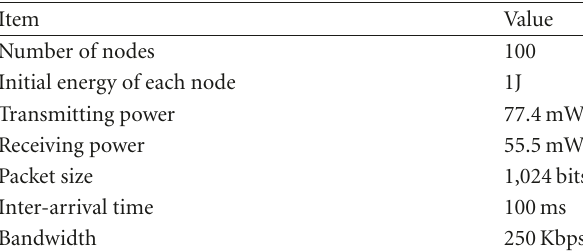
Figure 3: Estimated delay versus measured delay. Table 1: Configuring of experiment parameters.